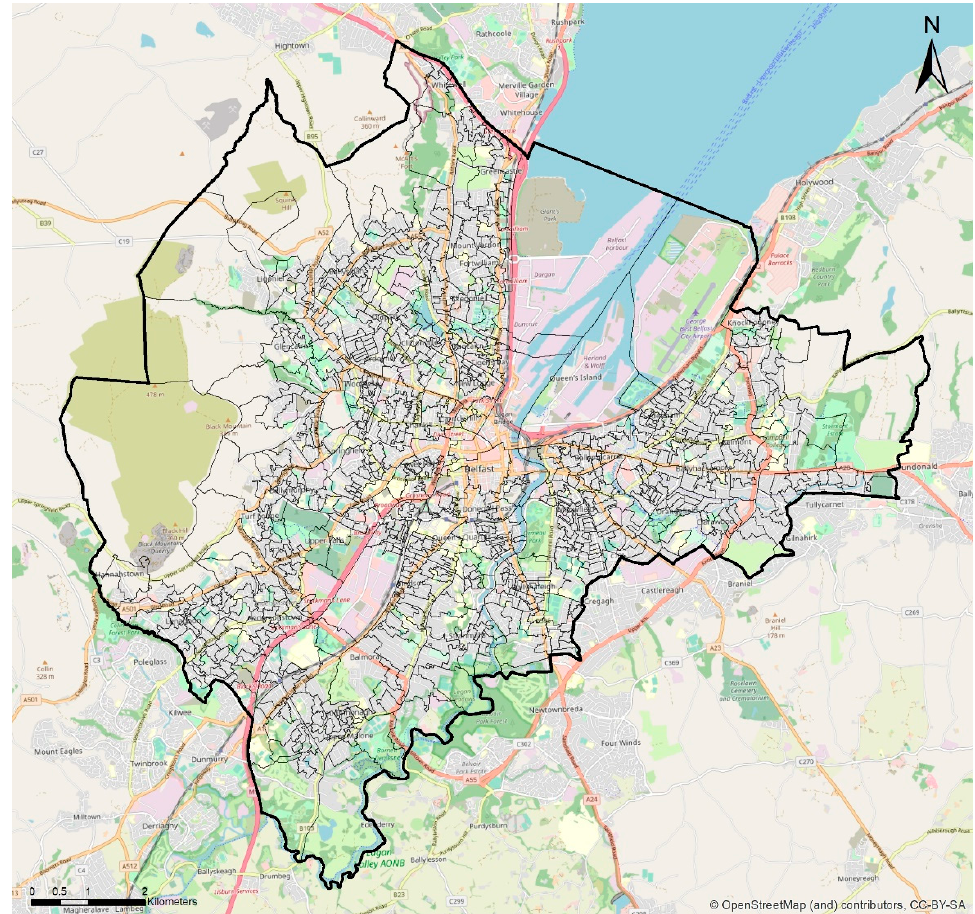
Figure 1. Map of the City of Belfast study area and the ‘small areas’.